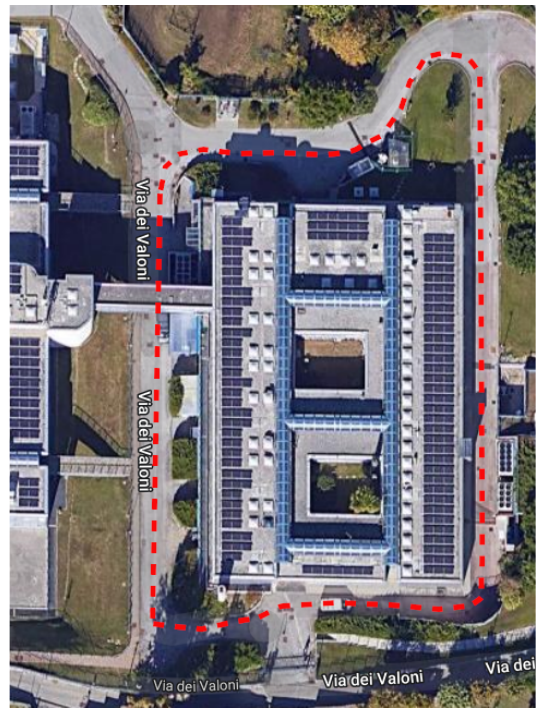
Figure 4: Orthophoto of the FBK building used for our tests. Image source: Google